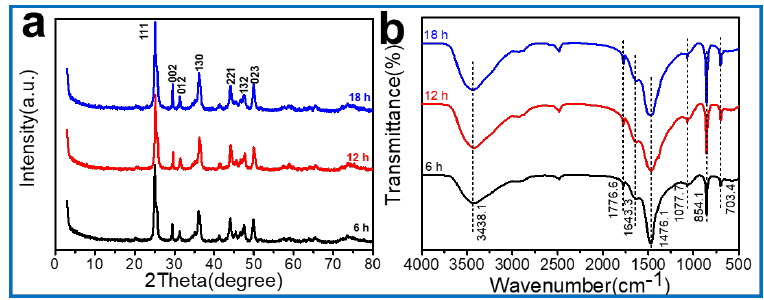
Figure 2. ( a ) XRD patterns and ( b ) Fourier-transform infrared (FT-IR) spectrum of strontium carbonate obtained in the absence of nano-MMT when the mineralization time was 6 h, 12 h, and 18 h, respectively.